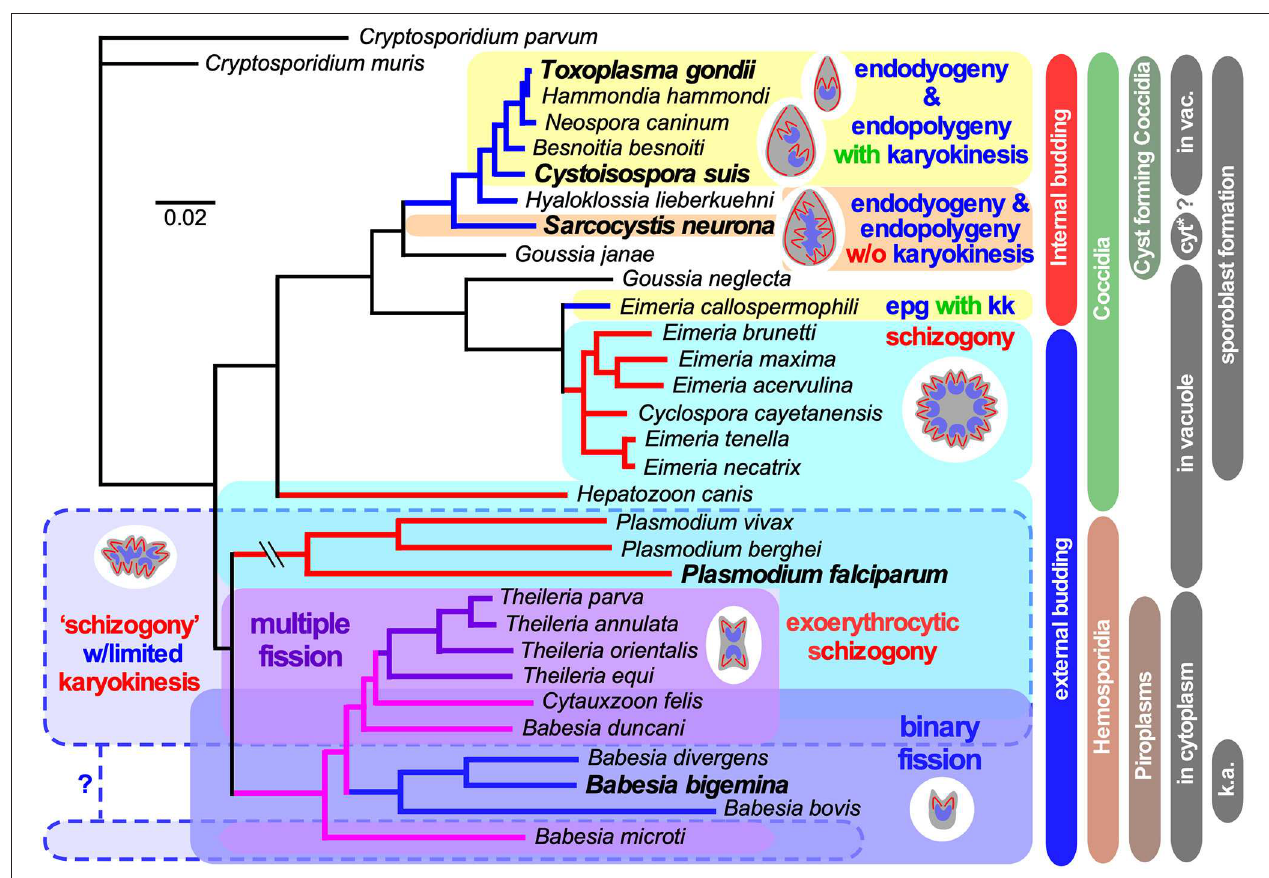
FIGURE 1 | Select apicomplexan phylogeny and division modes. 18S ribosomal RNA based phylogeny of species whose division modes have been studied. Cryptosporidium spp. were used as outgroup. Bars on the right indicate different naming and biological relationships, with asexual division modes in blue and red. “in vacuole” and “in cytoplasm” indicate whether asexual replication occurs in a parasitophorous vacuole, or whether the parasite escapes from the vacuole and resides in the cytoplasm of the host cell for its replication. Note that only the acute stage merozoites of S. neurona replicates by endopolygeny in the cytoplasm, whereas metrocytes preceding the bradyzoites as well as the bradyzoites divide by endodyogeny within a vacuole supporting a proteoglycan cyst wall. Furthermore, tissue cysts for C. suis have not been described and this lacking ability is likely a secondary loss. In addition, for several Plasmodium spp. ( Simonetti, 1996), as well as Babesia and Theileria spp. ( Jalovecka et al., 2018) it has been shown that sporozoite formation progresses without karyokinesis to produce large polyploid nuclei while budding is from the cortex. We note that Plasmodium sporozoites infect hepatocytes wherein they divide by schizogony and manipulate the hepatocytes to expand their size, whereas Theileria sporozoites infect white blood cells, replicate by schizogony ( Shaw and Tilney, 1992) and trigger white blood expansion as well as division (i.e., transformation, which basically is leukemia ( Luder et al., 2009; Chakraborty et al., 2017), which contrasts with Babesia sporozoites as they directly infect red blood cells. “epg with kk” means “endopolygeny with karyokinesis,” in case of select Babesia spp., “k.a.” means “kinete